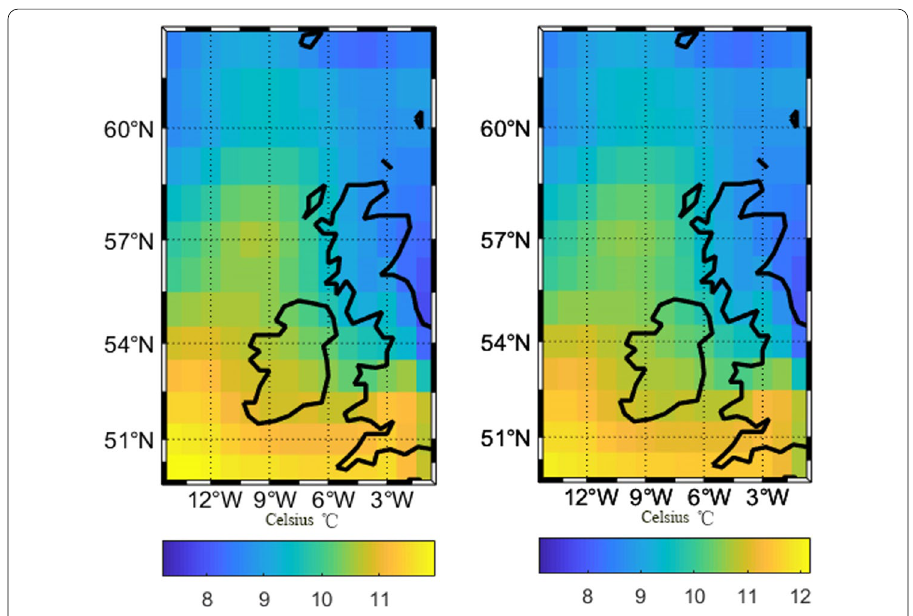
Fig. 1 Results of model (left is the real situation; right is the model